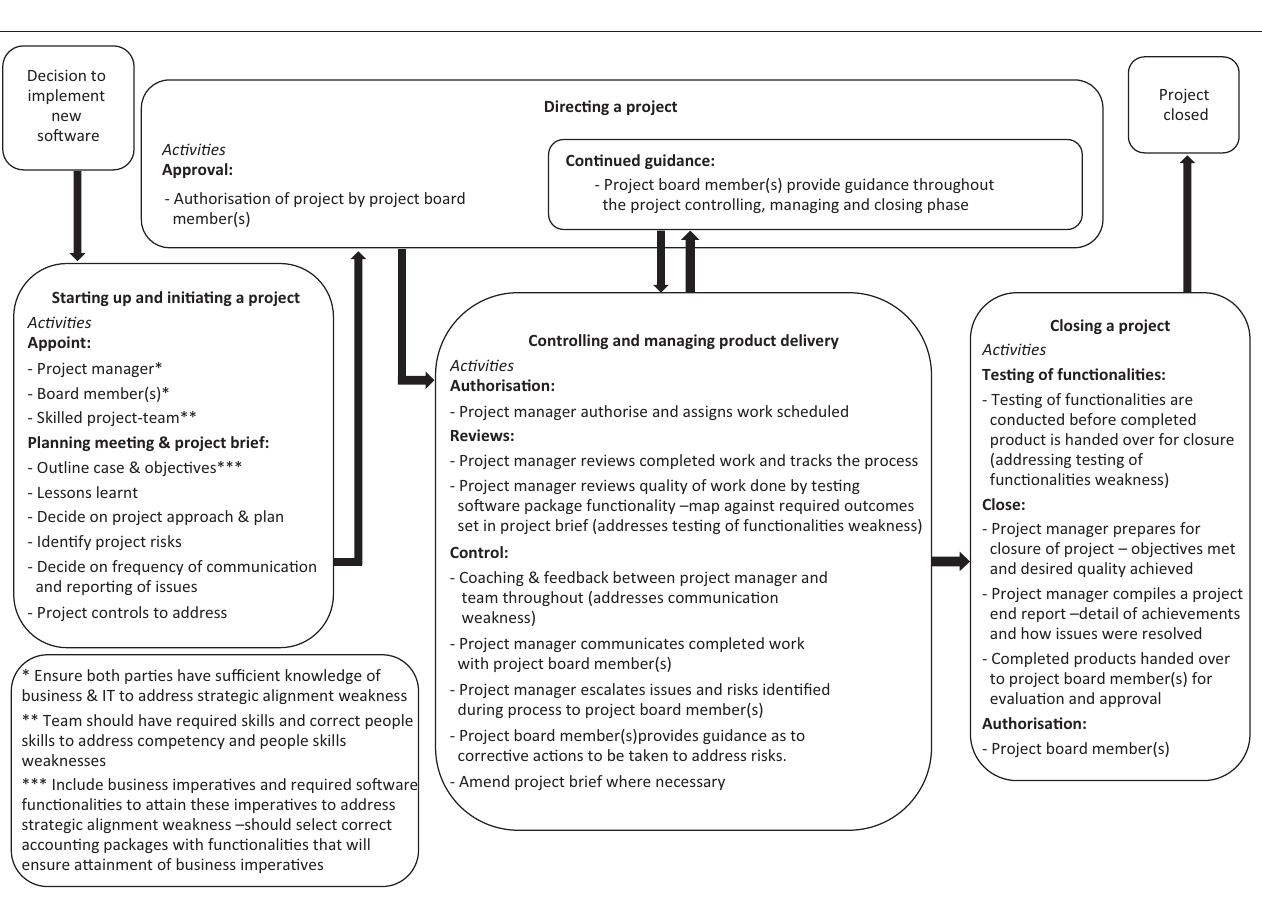
FIGURE 2: Projects in Controlled Environments for small- and medium-sized entities (accounting software implementation) – tailored process